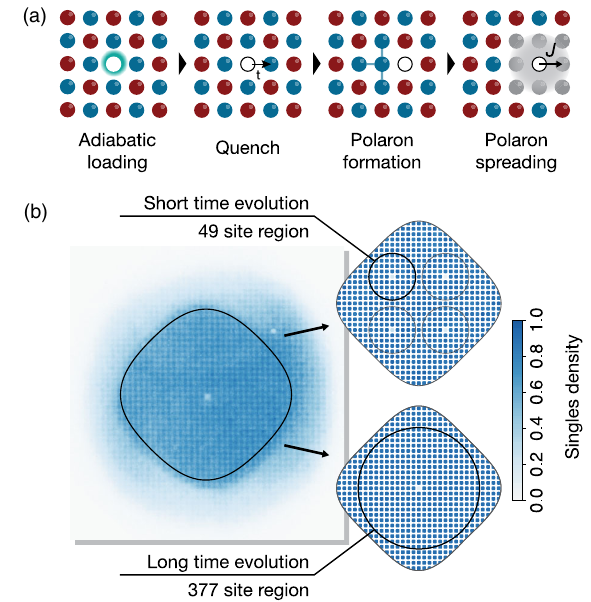
FIG. 1. Probing single-hole dynamics with a quantum gas microscope. (a) We initialize a hole in the system by adiabatically loading atoms into the lattice with a localized repulsive potential. The potential is abruptly removed, allowing the hole to delocalize at the bare tunneling rate t and displace spins along its path that result in a local reversal of spin correlations compared to equilibrium. The hole is therefore locally dressed by the spin background, forming a magnetic polaron with a velocity ultimately determined by J . (b) Left: average of experimental images before hole release for one prepared hole. The apparent additional hole in the upper right is caused by defects in the imaging path. Right: average density of the atomic system before hole release, for one hole and four holes (to enhance the data collection rate at short evolution times). All analysis is done inside the denoted